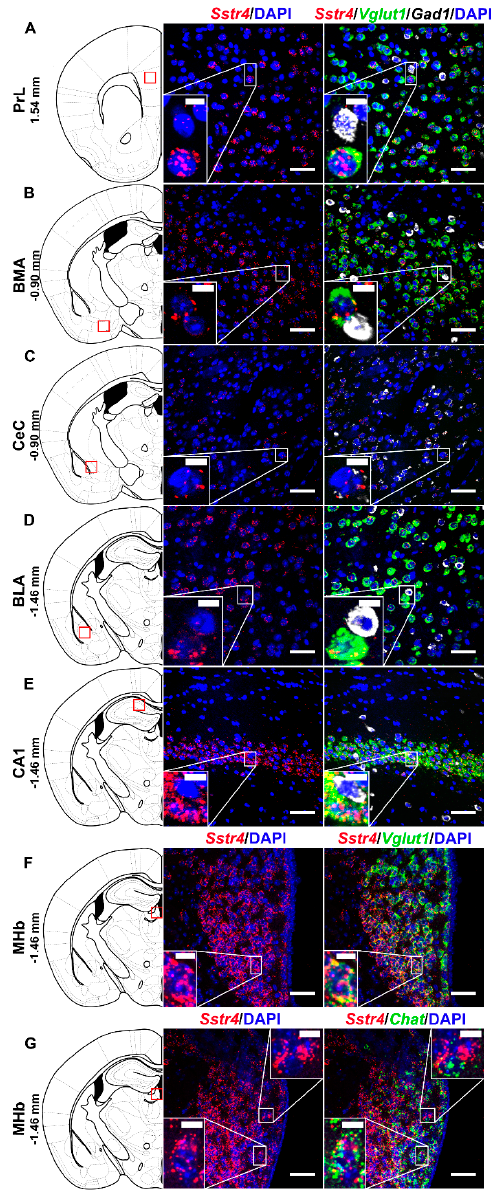
Figure 5. Representative Sstr4 , Vglut1 , Gad1 and Chat mRNA expression in various brain areas of WT mice. Sstr4 (red), Vglut1 (green), and Gad1 mRNA (white) expression counterstained with DAPI are shown in the prelimbic cortex (PrL, Bregma 1.54 mm, ( A )), in the basomedial amygdala (BMA, Bregma − 0.9 mm, ( B )), in the core of central amygdala (CeC, Bregma − 0.9 mm, ( C )), in the basolateral amygdala (BLA, Bregma − 1.46 mm, ( D )), in the CA1 of hippocampus (CA1, Bregma − 1.46 mm, ( E )) ( N = 5). Sstr4 (red) and Vglut1 (green) expression counterstained with DAPI are shown in the medial nucleus of habenula (MHb, Bregma − 1.46 mm, N = 3, ( F )). Sstr4 (red) and Chat (green) expression counterstained with DAPI are shown in the MHb ( N = 2, ( G )). Scale bar: 50 µ m, inset scale bar: 10 µ